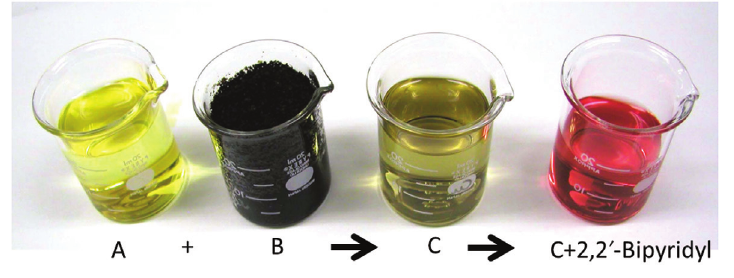
) with (B) tea dregs or coffee grounds and (C) 3